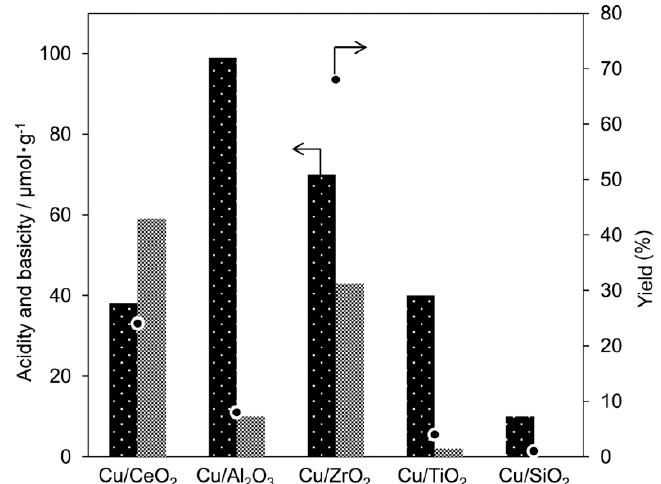
Figure 8. Relationship between the amount of acid (white squares with black background) and base (chessboard pattern) of different catalysts and their octyl octanoate yield (•) [39] (https://pubs.acs.org/doi/10.1021/acsomega.7b01142). Reprinted with the permission of the American Chemical Society; further permissions related to the material excerpted should be directed to the